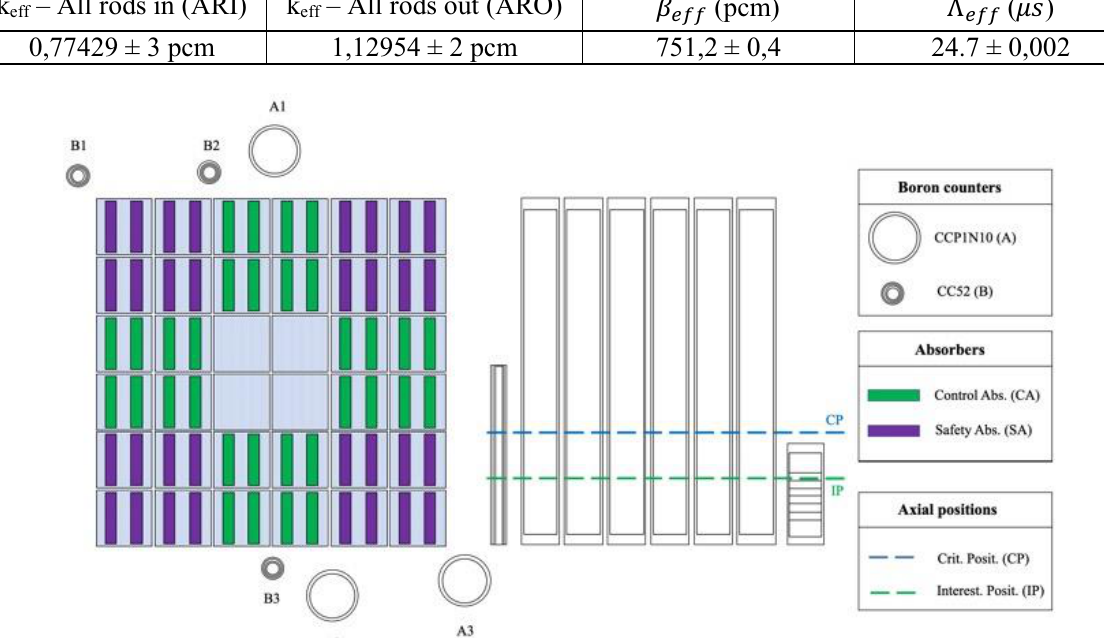
Table I. Main neutronics parameters of “fictitious core” (uncertainties are given for 2 6 )